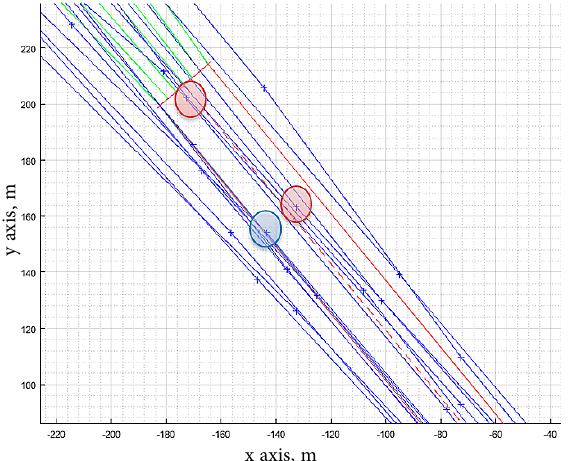
Fig. 16. Runway zone of the flight circuit (red rectangular) Secondly, the aircraft may enter the runway area not by crossing the RW threshold but by crossing its side (blue blurb in Fig. 16). In this case, the return of the alti- tude graph to the start is also delayed.